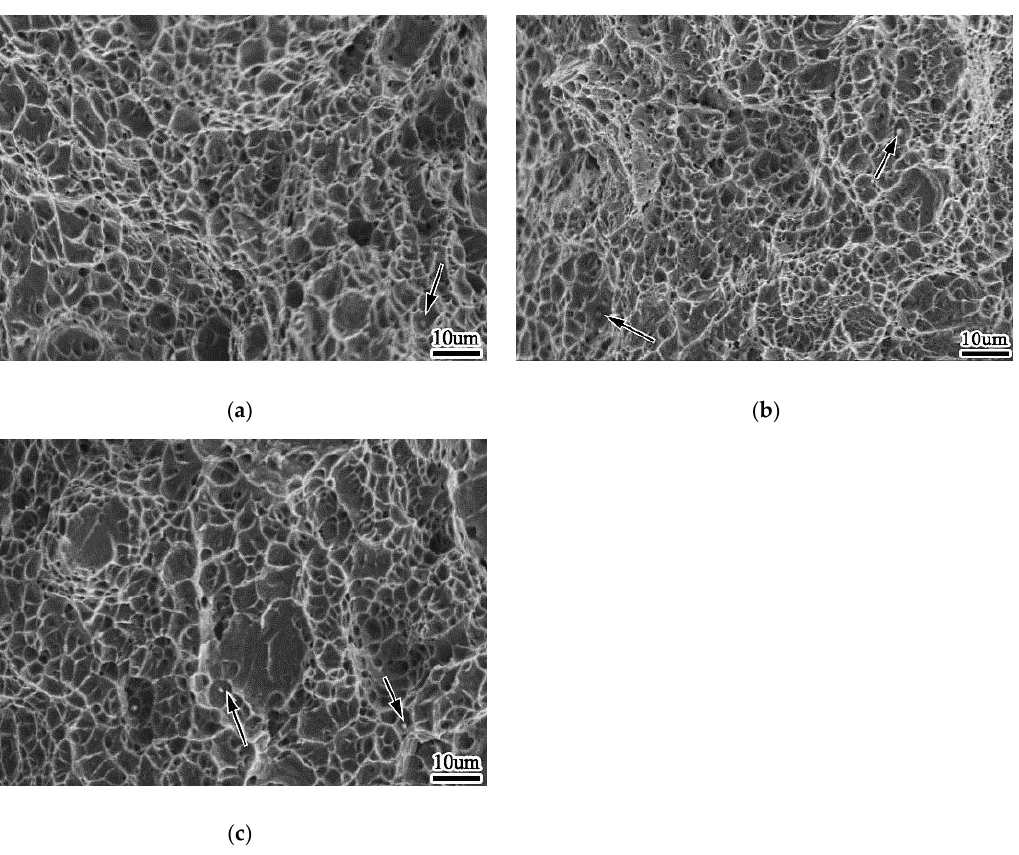
Table 8. Inclusion composition of tensile fracture.